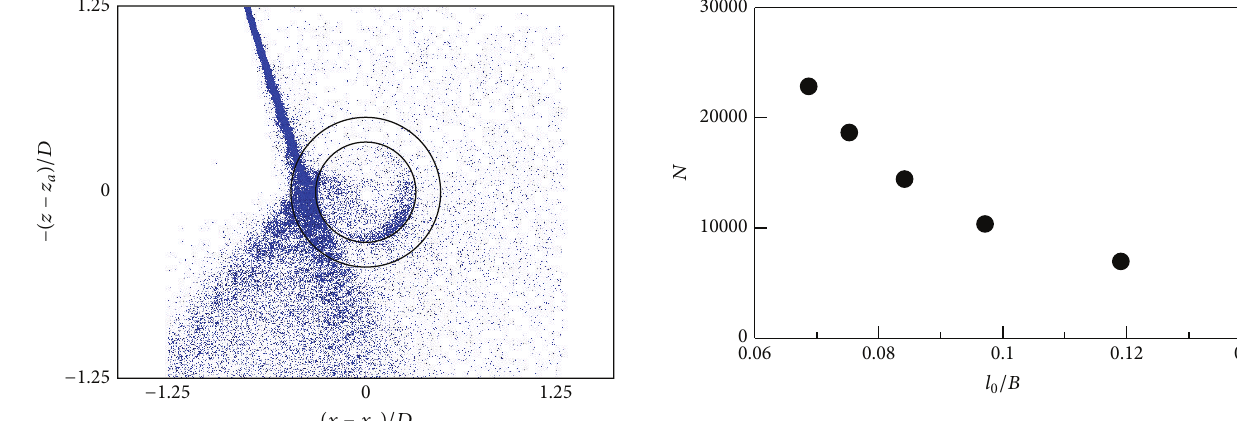
Figure 8: Change in number of particles 𝑁 due to distance between particles 𝑙 0 when 𝜆 = 0.56 . Table 1: Simulation